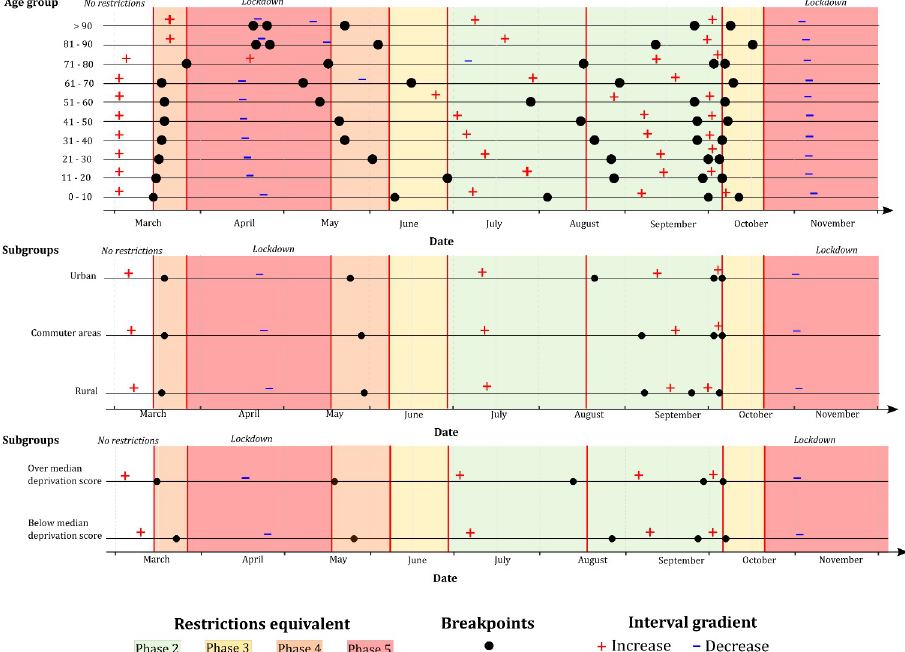
Fig 6. Grid synthesis of (top) age-related deciles, (middle) urban/commuter/rural classification, and (bottom) above/below median deprivation score time-series breakpoint models (psi = 5) in the Republic of Ireland (cases/ day), February 29 th to November 30 th 2020; + and - signs refer to positive and negative interval gradients, respectively.